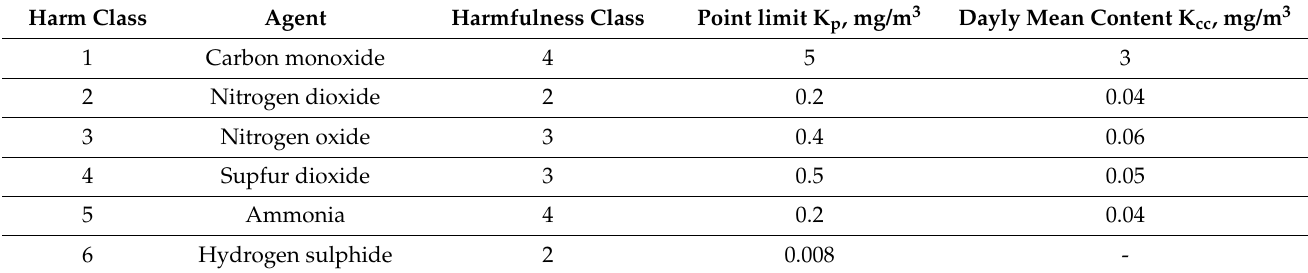
Table 4. Limits of harmful atmospheric